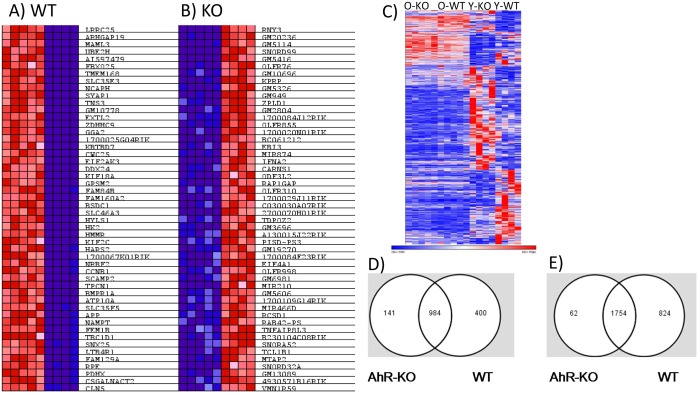
Aging alone changes gene expression in LT-HSCs.Previously published array data on young animals (6) was compared with current data to generate a heat map of top 100 differentially expressed/enriched genes between Old/Young WT (A) and Old/Young AhR-KO (B). (C) Heatmap showing array data for all ages examined. Subsequent analyses focused on genes that require both age and lack of AhR to display differential expression. 203 genes were found to be dependent on lack of AhR and aging, and included 141 up-regulated and 62 down-regulated genes. Overlap of gene changes that occurred in Old/Young WT and Old/Young AhR-KO (D = up-regulated genes, E = down-regulated genes).